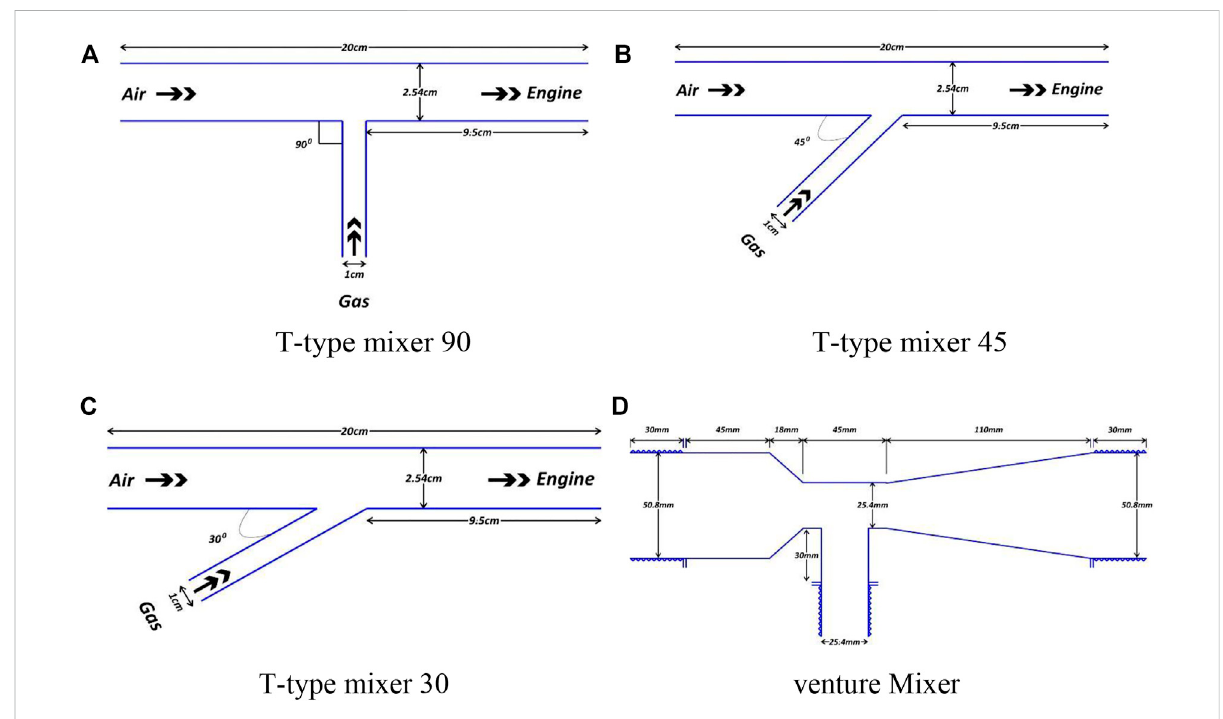
FIGURE 2 Schematic diagram of the types of gas